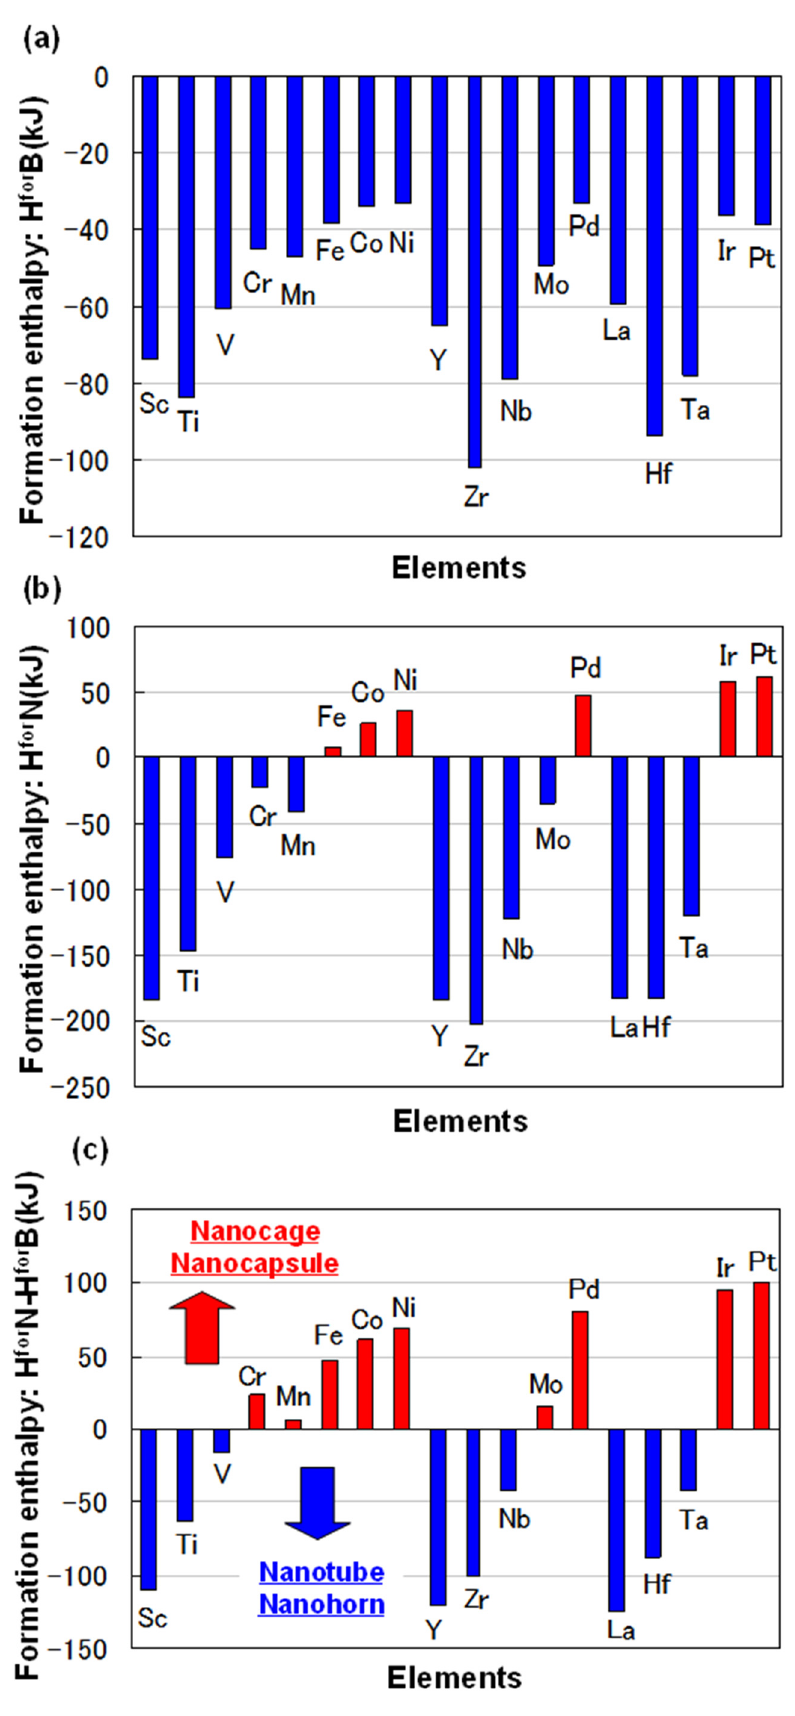
Figure 1. ( a ) Formation enthalpy with boron (H for B) and ( b ) nitrogen (H for N); ( c ) difference of formation enthalpy (H for N-H for